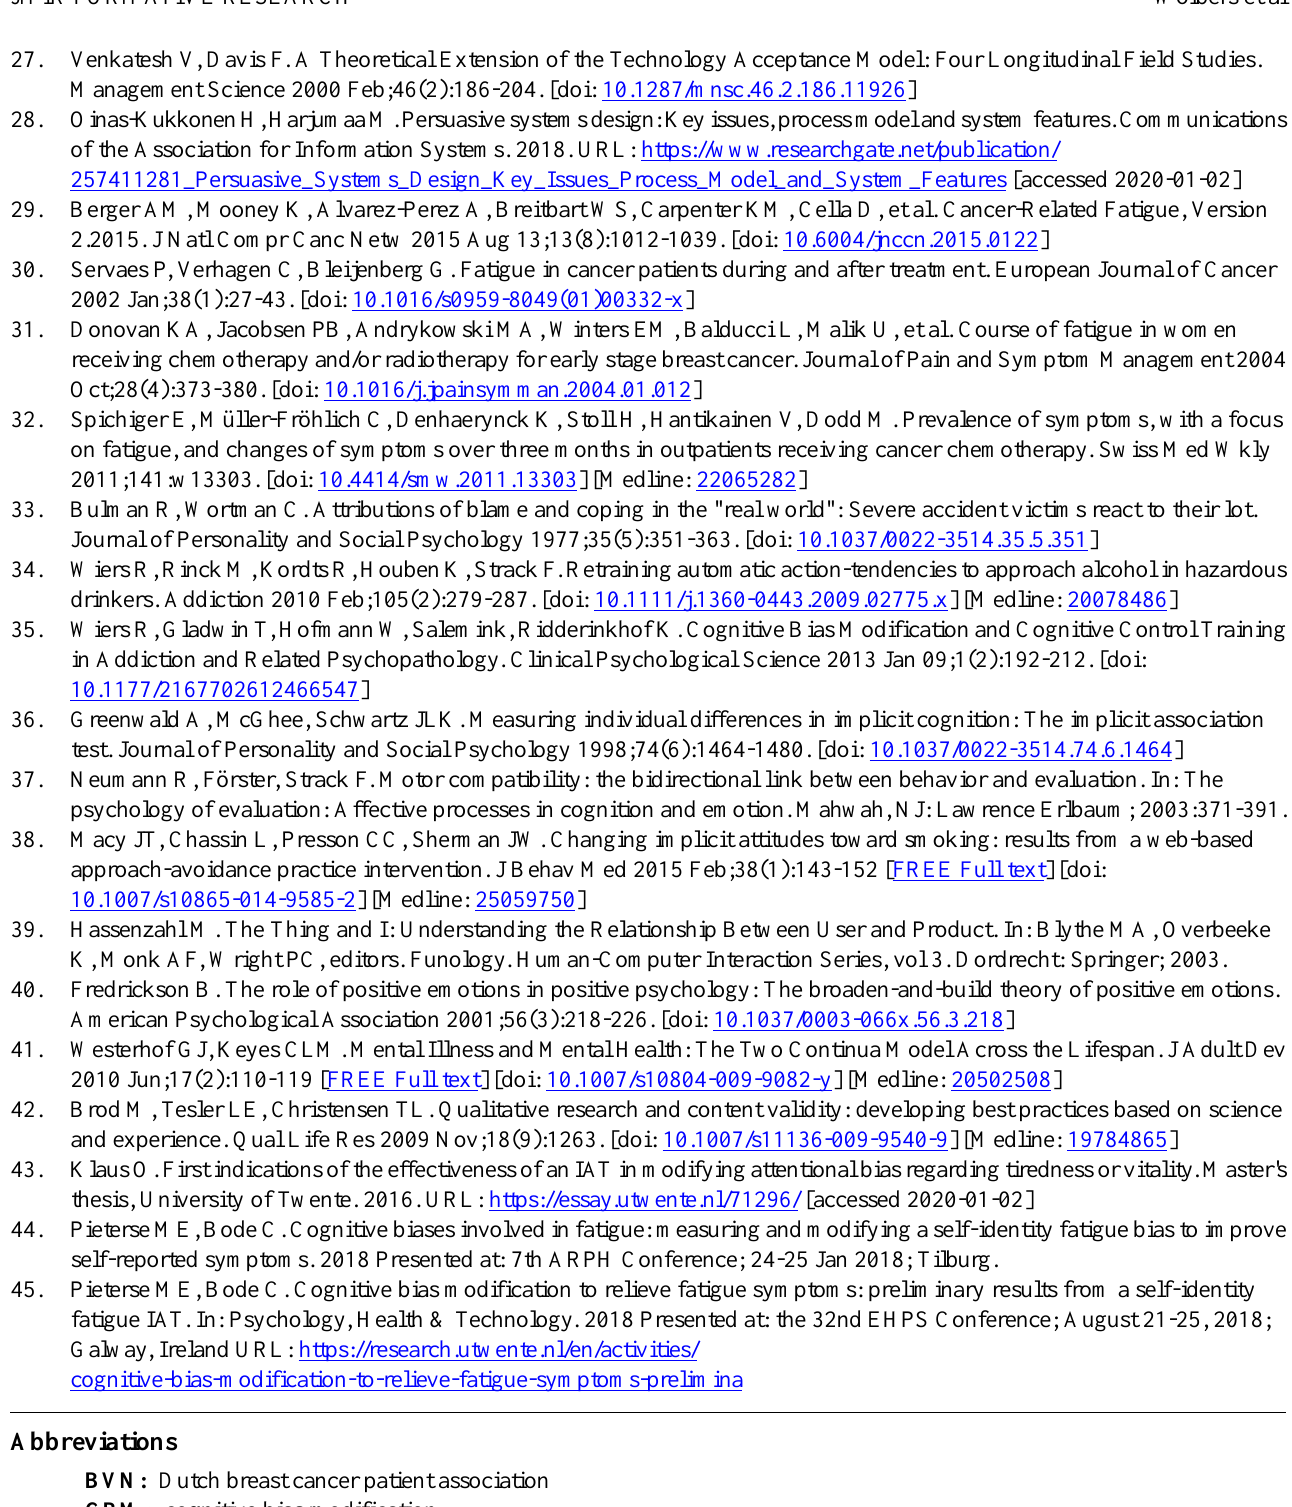
Abbreviations BVN: Dutch breast cancer patient association CBM: cognitive bias